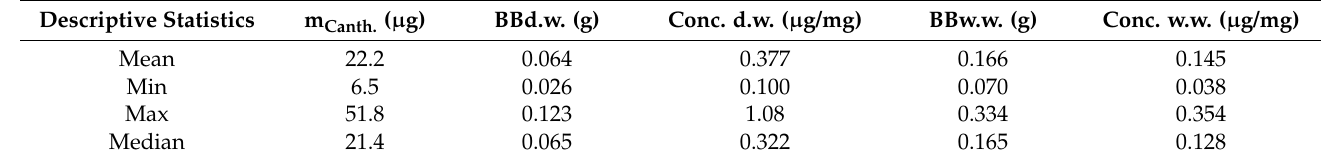
Table 1. Cantharidin in blister beetles analyzed with LC-MS/MS.